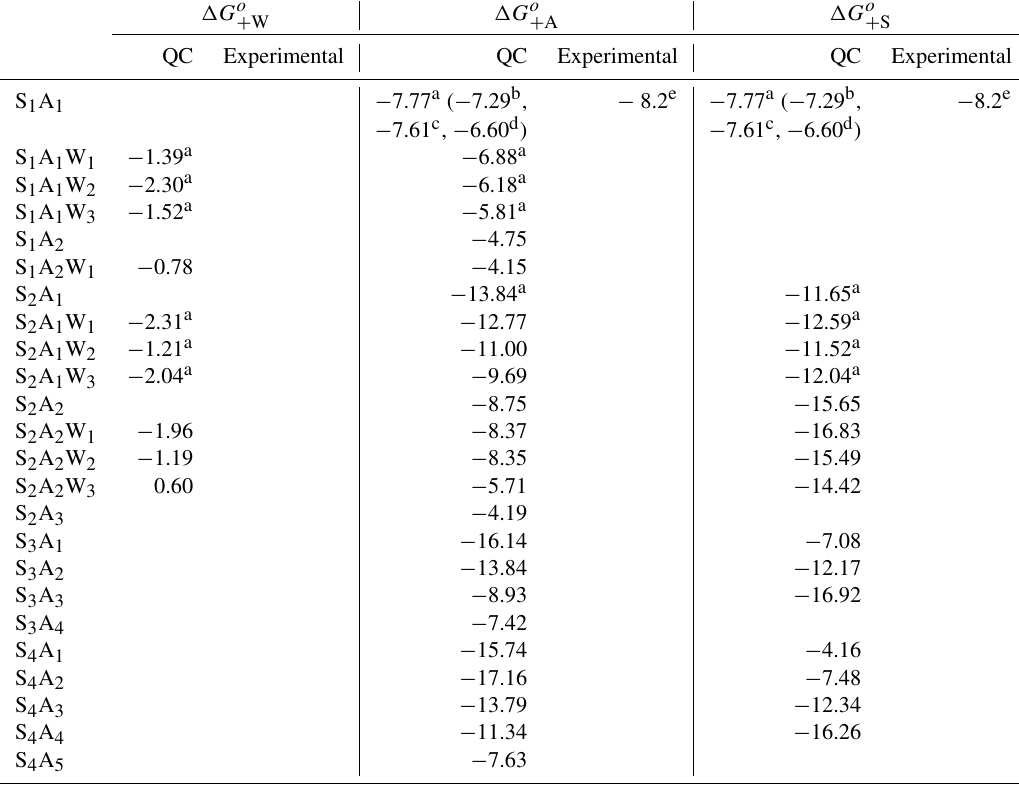
Table A3. Same as Table A2 except for neutral